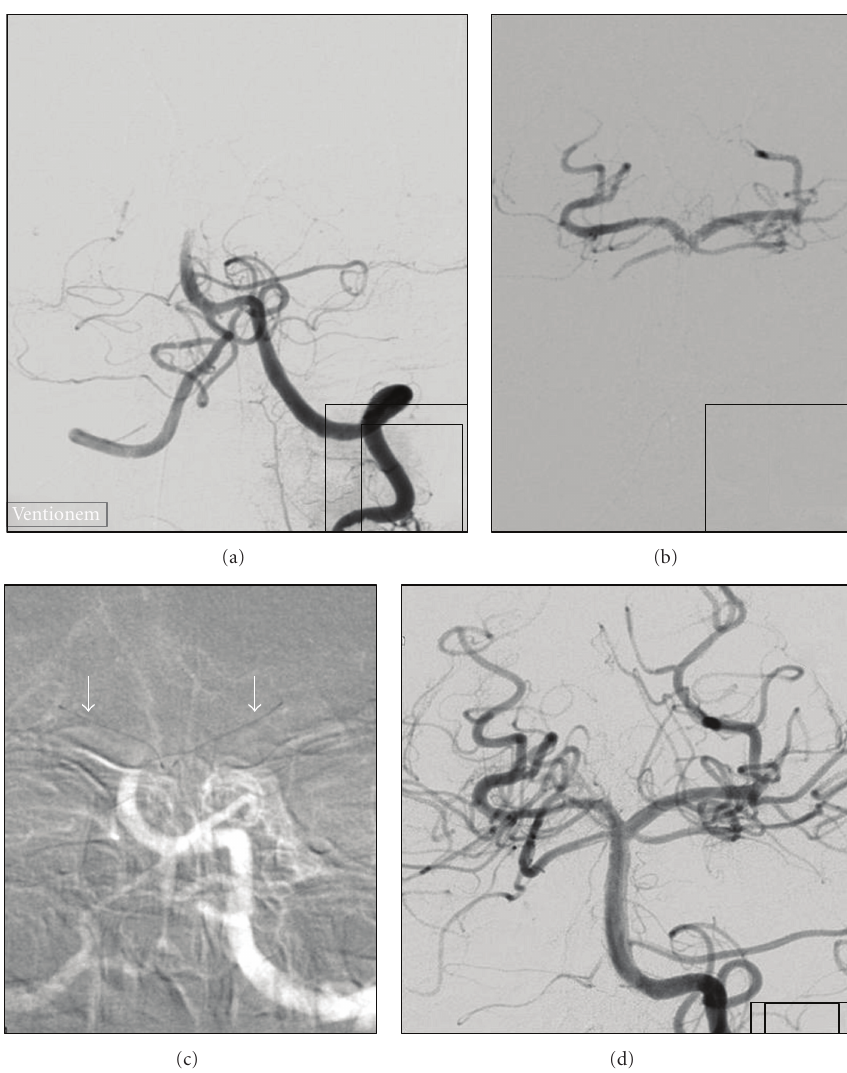
Figure 3: (a) Acute distal basilar artery occlusion, application of 10 mg IA rtPA without visible e ff ect; (b) passage of the thrombus with guidewire and microcatheter, tip of the basilar artery and both posterior cerebral arteries are open; (c) placement of pCR 2/4/20 in each P1-segment of the posterior cerebral artery (arrows); (d) simultaneous retraction of the thrombectomy device into the guiding catheter leads immediately to full (TICI 3) reperfusion (kissing